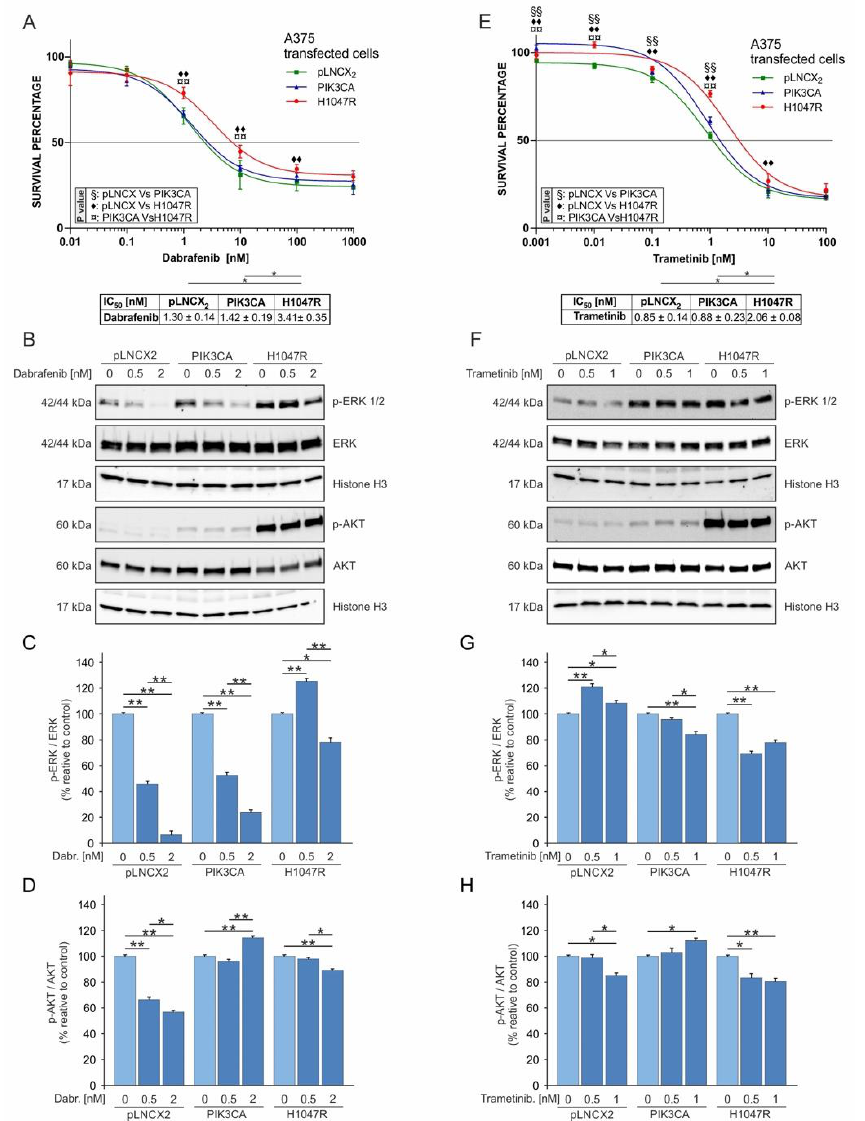
Figure 3. Dabrafenib and trametinib treatment of A375 pLNCX2 , A375 PIK3CA , and A375 H1047R cells. ( A ) Cell viability evaluated through the MTT assay after 72 h of dabrafenib treatment at different concentrations (0.01–0.1–1–10–100–1000 nM). ( B – D ) Western blot analyses of p-ERK, p-AKT, total ERK, and total AKT protein levels and their ratio in A375 transduced cells treated with dabrafenib (0.0–0.5–2 nM) for 48 h. ( E ) Cell viability (MTT assay 72 h) of A375 clones treated with trametinib (0.001–0.01–0.1–1–10–100 nM). ( F – H ) Western blot analysis of p-ERK, p-AKT, total ERK, and total AKT protein levels in A375 cells treated with trametinib (0.0–0.5–1 nM) for 48 h. All experiments were performed in triplicate. * p ≤ 0.05; ** p ≤ 0.01; ◆, §, ¤ = p ≤ 0.05; ◆◆, §§, ¤¤ = p ≤ 0.01.